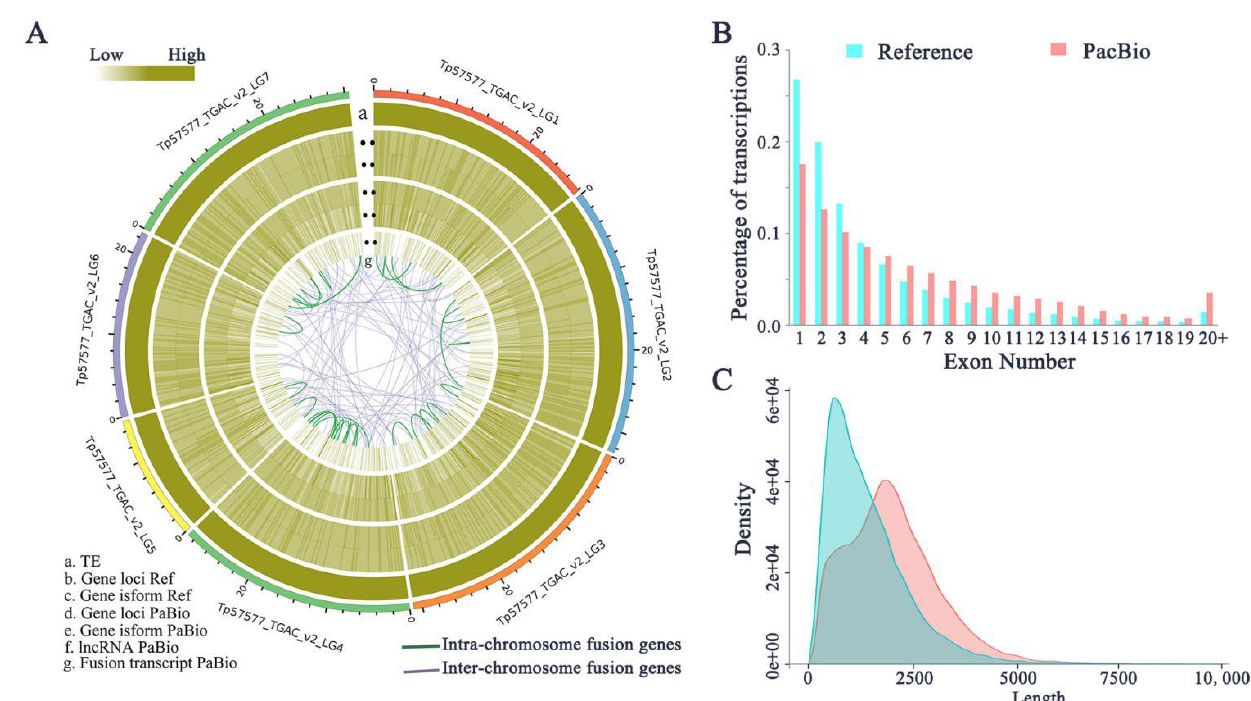
Figure 1. Comparison of the isoform annotations of the red clover v2.0 (reference) and PacBio Iso-Seq dataset. ( A ) Distribution of genomic features within the PacBio isoform dataset against the Tp_v2.0 genome assembly. ( B ) Distribution of the percentage of transcripts with different exon numbers in the reference genome and in the PacBio Iso-Seq dataset. ( C ) Comparison of isoform length in the gene model and PacBio Iso-seq dataset.